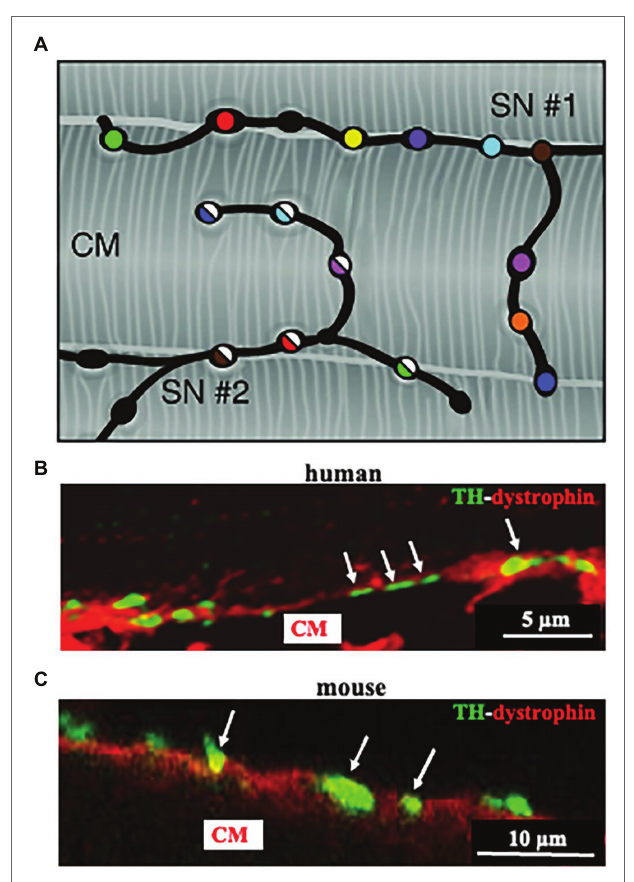
FIGURE 3 | Cardiac sympathetic neurons contact cardiomyocyte membrane at multiples sites. (A) Each CM is simultaneously innervated by different neuronal processes (two different processes in the picture are represented by filled or half-filled circles, respectively), all of which are characterized by regularly distributed varicosities, each highlighted by one color. (B,C) Confocal immunofluorescence imaging of a thin ventricular section of a normal mouse (B) , or human (C) heart, stained with antibodies to tyrosine hydroxylase (TH) and dystrophin. Modified with permission from Zaglia and Mongillo (2017) (A) Prando et al. (2018) (B,C) .